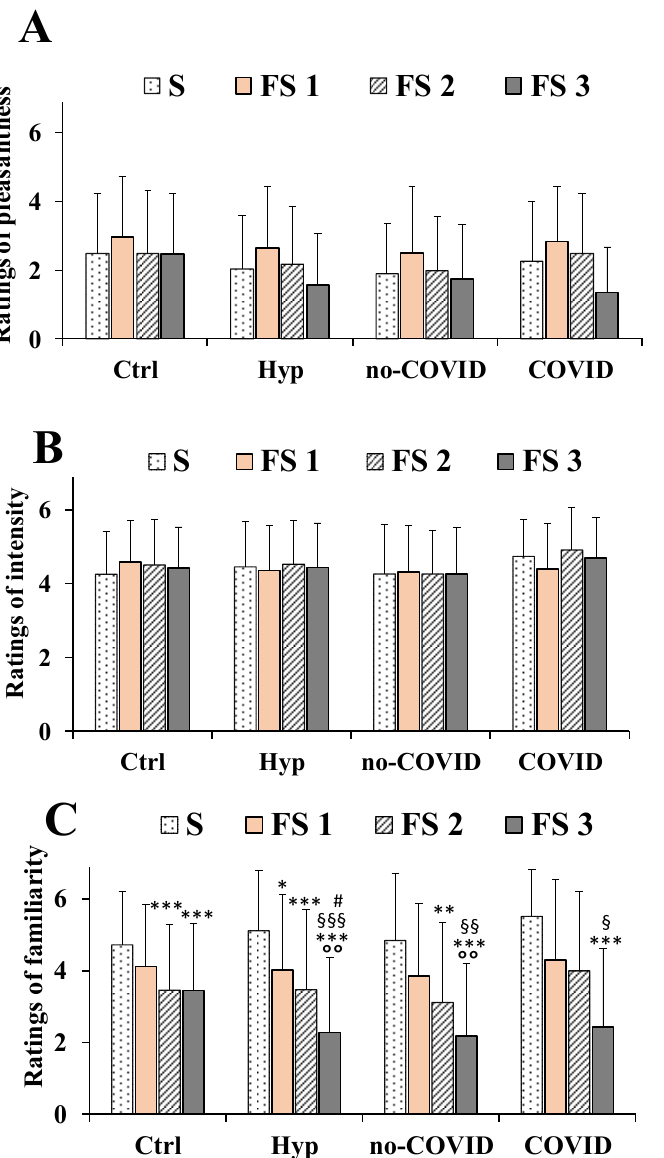
Figure 5. Ratings of pleasantness ( A ), intensity ( B ), and familiarity ( C ) dimensions measured in total patients with hyposmia (Hyp, n = 57), subjects without (no-COVID, n = 34) or with (COVID, n = 23) post-acute Coronavirus Syndrome compared to healthy controls (Ctrl, n = 91), in response to saline solutions obtained with pure salt (S) and flavored sea salts of myrtle (FS 1), of Mediterranean herbs/plants (FS 2), and of orange/saffron (FS 3) at the concentrations of 0.04 g/mL. Data are presented as mean values and standard deviations. Significant differences among the four different groups of subjects (as between factors) in relation to type of salt (S, FS 1, FS 2, and FS 3 as within factor) were calculated using a two-way repeated measures ANOVA. ◦◦ = p < 0.01 versus respective Ctrl; *** = p < 0.001, ** = p < 0.01, * = p < 0.05 versus S; §§§ = p < 0.001, §§ = p < 0.01, § = p < 0.05 versus FS 1; # = p < 0.05 versus FS